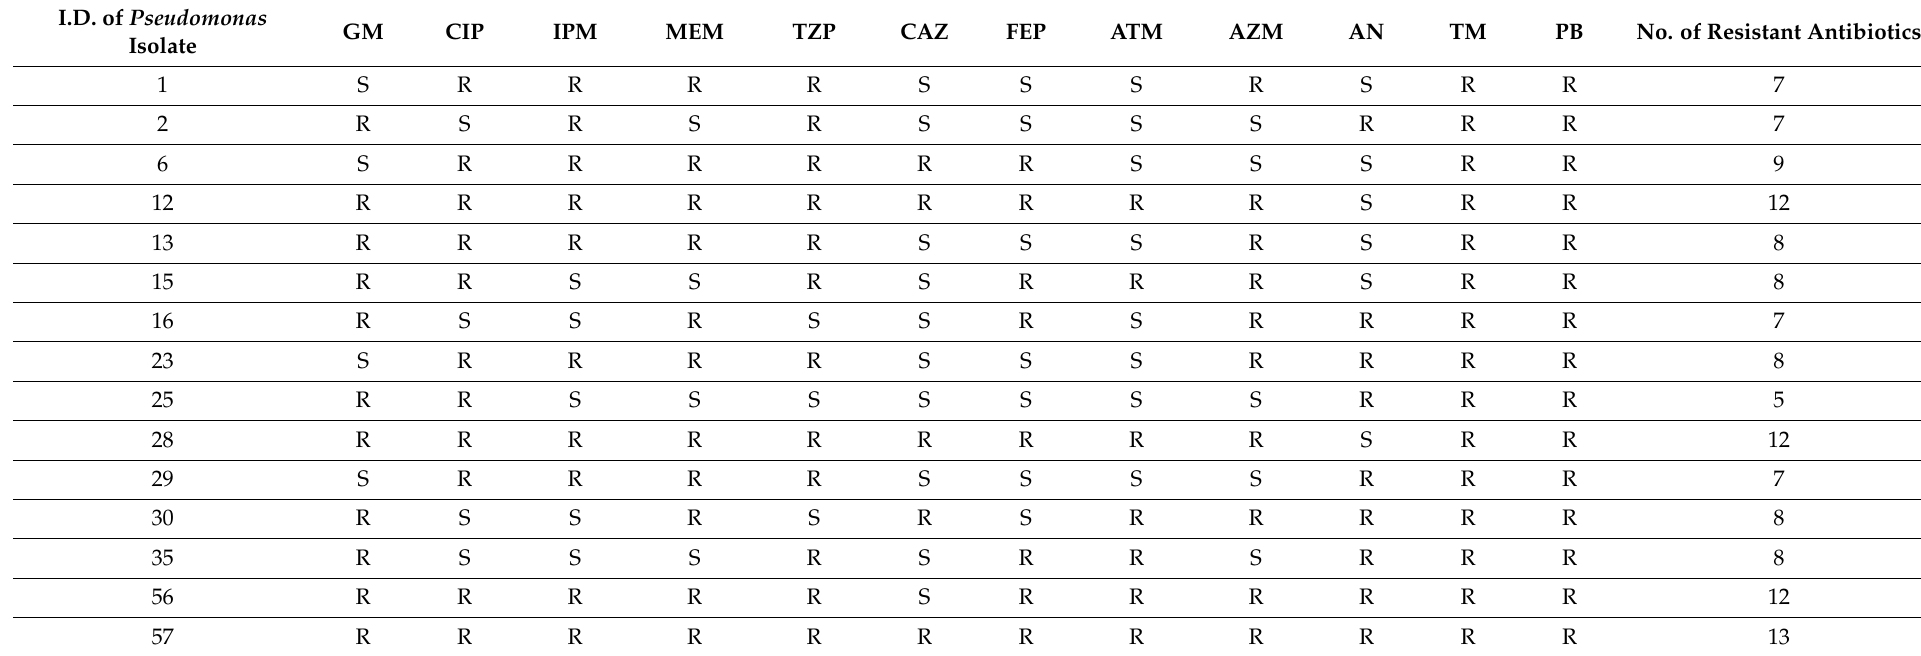
Table 5. Results of antibiotic susceptibility testing of Pseudomonas aeruginosa isolates from otitis externa ( n =